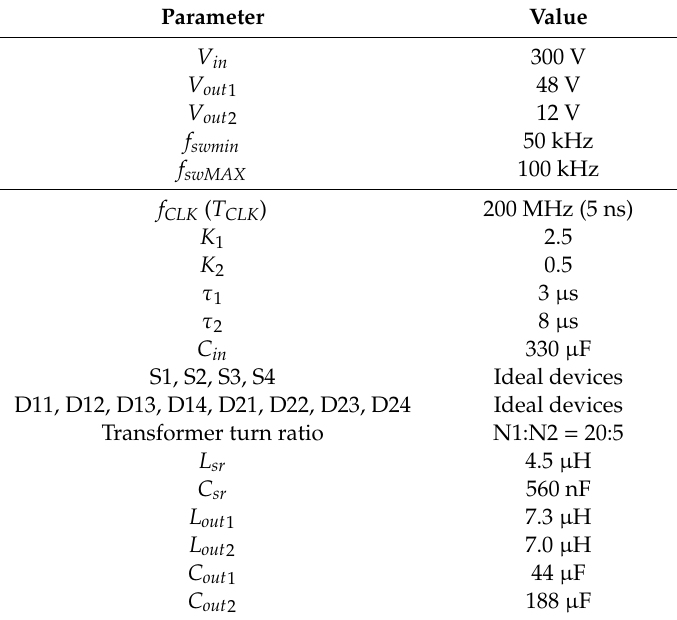
Table 3. Specifications of simulation circuit.